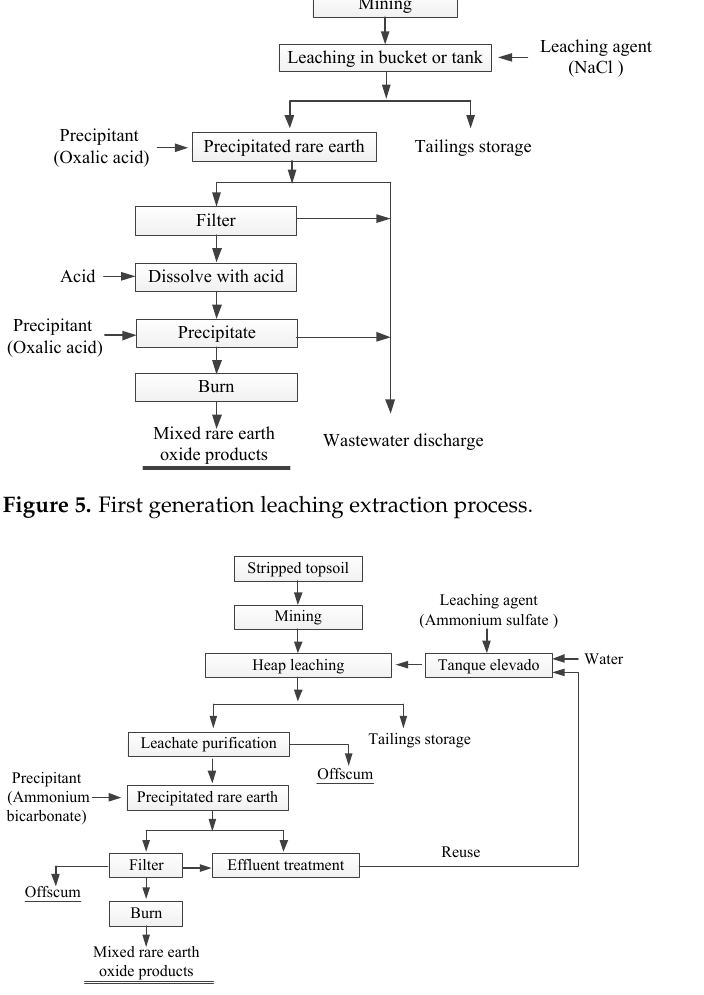
Reuse Figure 6. Second generation leaching extraction process.